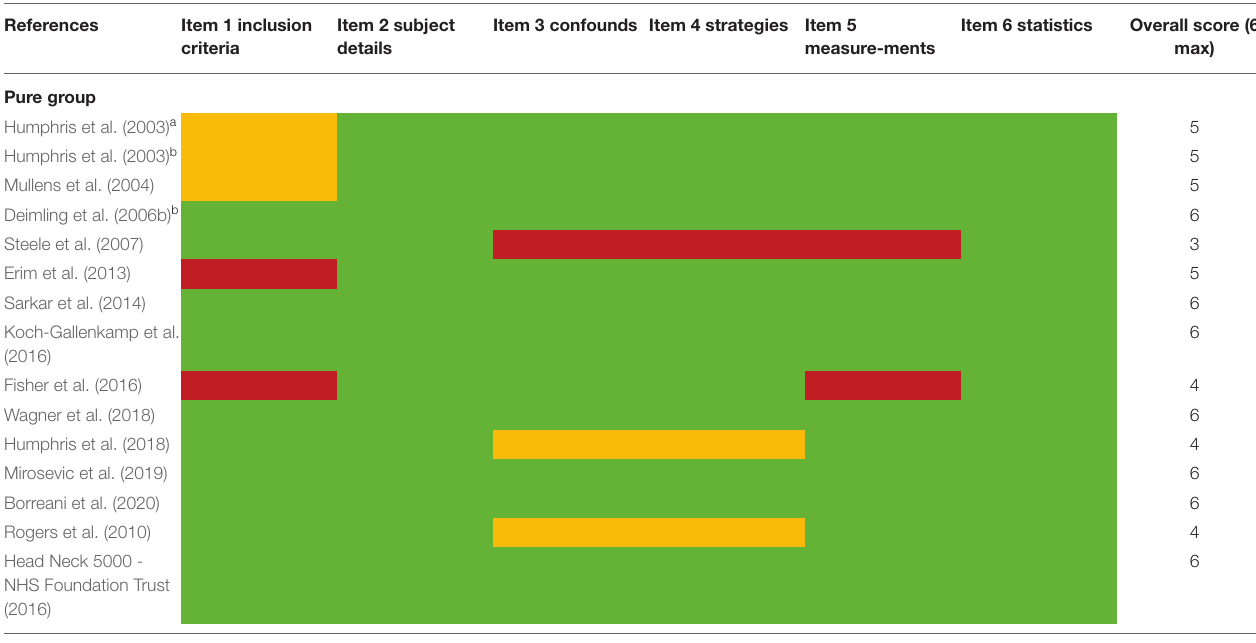
TABLE 2A | Quality assessment by modified Joanna Briggs tool on the included studies in pure group.